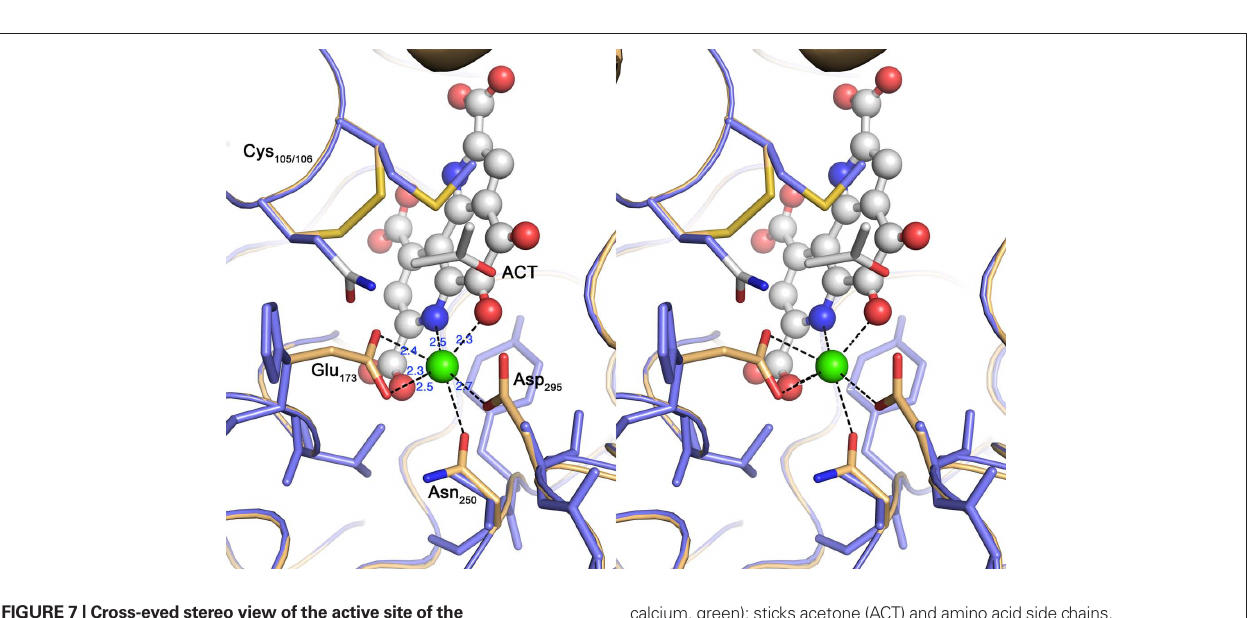
calcium, green); sticks acetone (ACT) and amino acid side chains. The calcium-coordinating side chains and the disulfide bridge characteristic for this type of proteins are highlighted; note the absence of the equivalent residues in the TTH model.